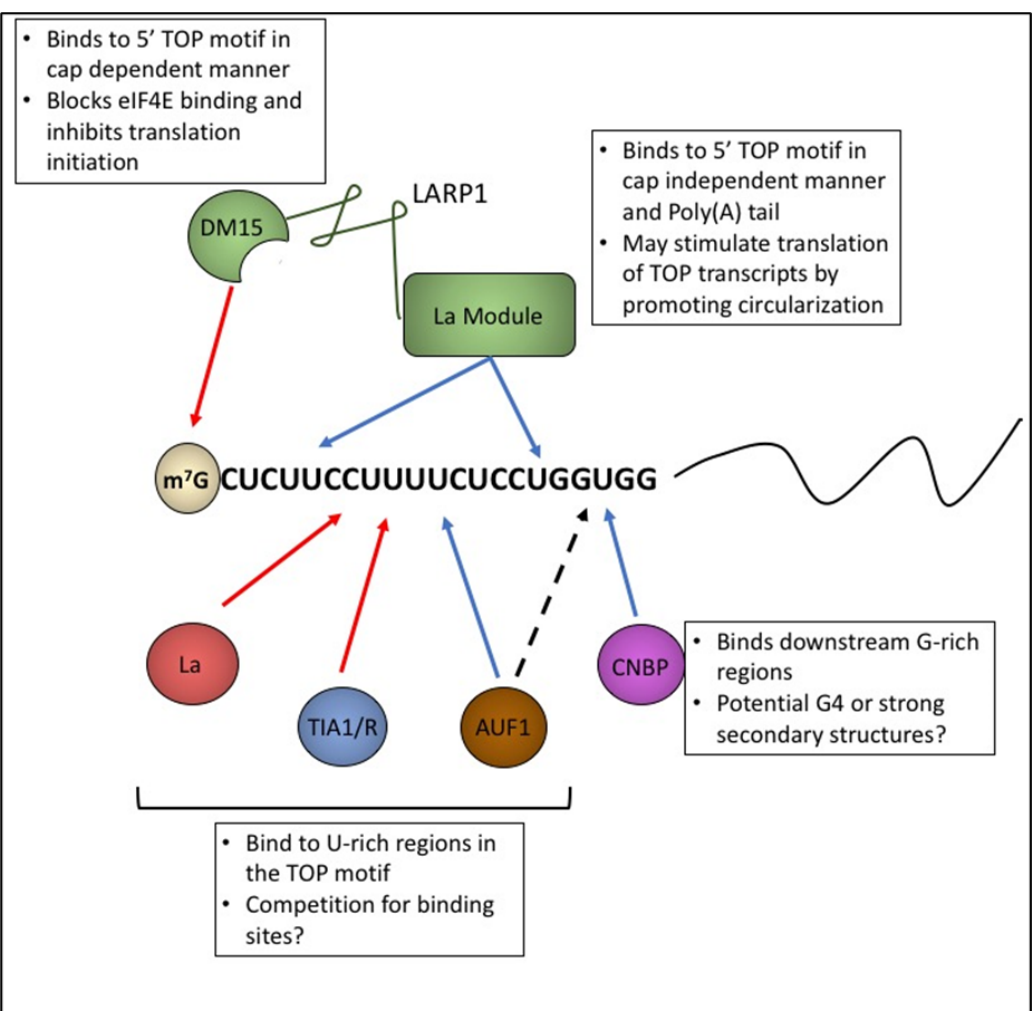
Figure 4. Multiple proteins bind to 5' TOP motifs and affect translation. Schematic depicting potential interactions of RNPs with the 5' TOP motif. Red arrows depict inhibition of expression and blue arrows depict promoting effects on expression. Different part of LARP1 (green) can interact with the TOP motif and can both promote or repress translation depending on the context. La (red) and TIA1/R (blue) bind to U-rich regions of the TOP motif and are thought to play an inhibitory role in TOP expression. AUF1 (brown) also binds to U-rich regions of the TOP motif but appears to have a promoting effect on expression. Furthermore, La, TIA1/R, and AUF1 may compete for binding sites. CNBP interacts with G-rich regions near the distal part of the TOP motif. CNBP as well as AUF1 may associate with secondary structures and potential G4 quadraplexes that may form in this region of some TOP motifs through their RGG motifs.